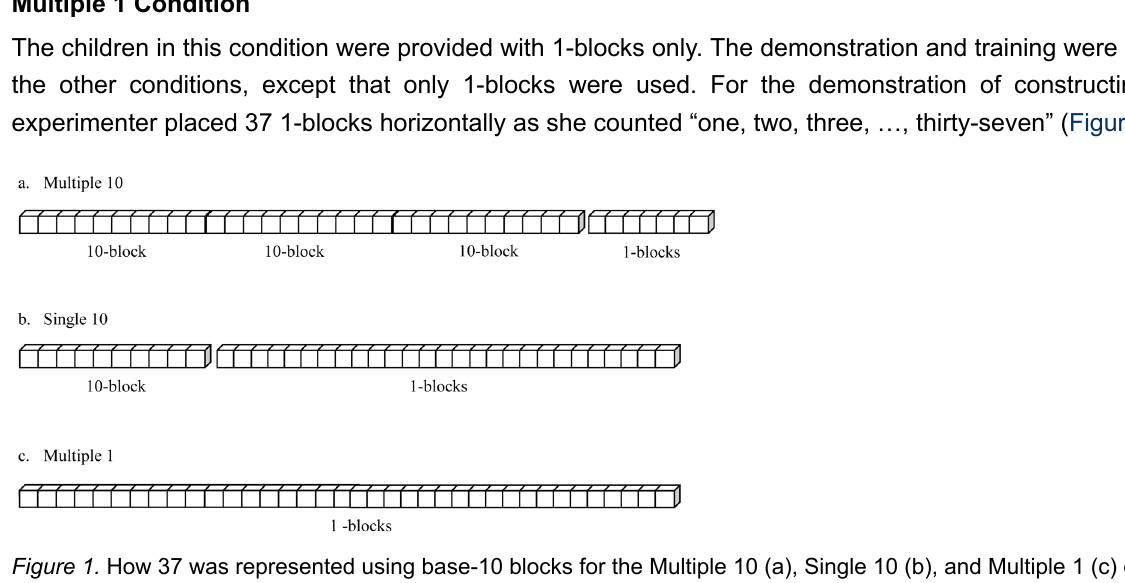
Figure 1. How 37 was represented using base-10 blocks for the Multiple 10 (a), Single 10 (b), and Multiple 1 (c) conditions. Note. Although the visuals in this figure show spaces to distinguish 10- and 1-blocks, children were encouraged to leave no space between any two adjacent